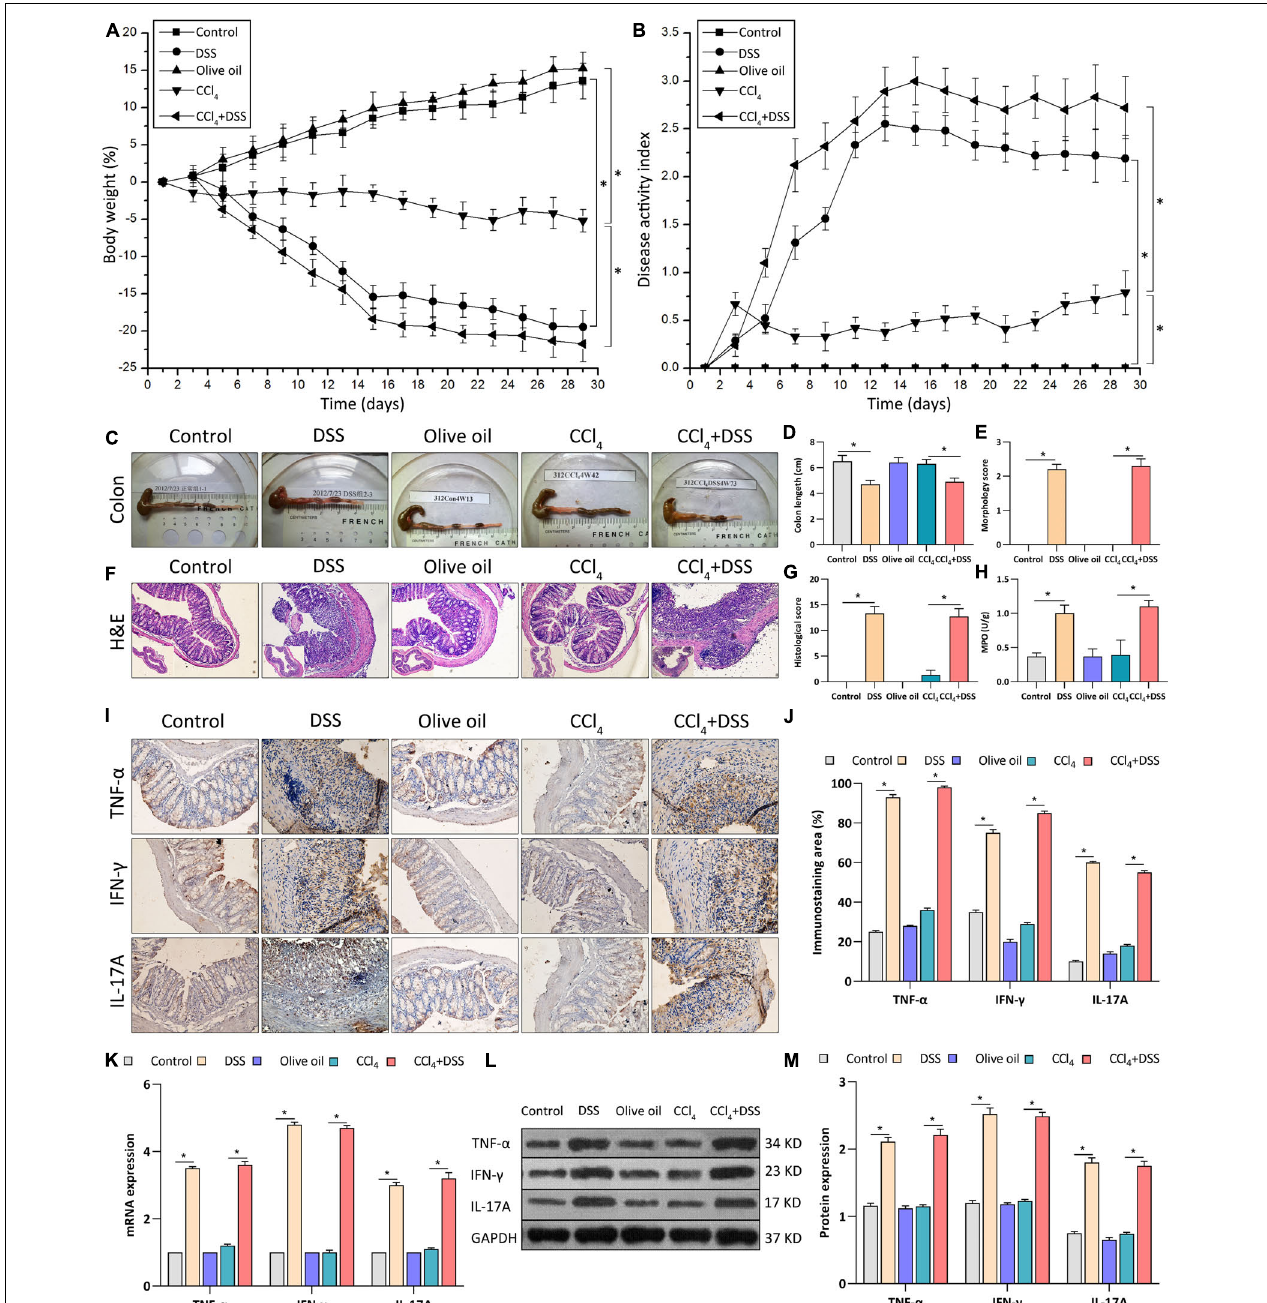
FIGURE 1 | DSS induced the intestinal inflammation in CCl 4 -induced liver fibrosis mice. (A) Changes of body weight during the experimental period; (B) Disease activity index was evaluated at indicated time points during the experimental period; (C) Representative colon specimen of mice from five groups were shown; (D) Colon length and (E) morphology score were quantified; (F) Representative images of H&E staining colon sections (magnifications × 200) and (G) histological score were shown; (H) Myeloperoxidase activity; (I) Representative images of IHC staining colon sections (magnifications × 400) and (J) staining intensity of pro-inflammatory cytokines were shown. (K–M) Expression levels of pro-inflammatory cytokines in colon were measured by qRT-PCR (K) and western blot (L,M) . Data were expressed as mean ± SD. *, p <